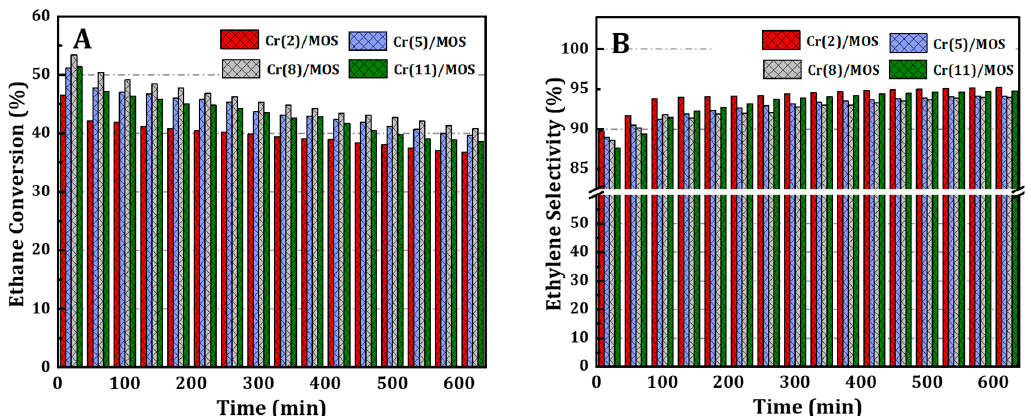
Figure 7. Variation of ethane conversion ( A ) and ethylene selectivity ( B ) time ‐ on ‐ stream over Cr(x)/MOS catalysts. Therefore, slight deactivation of the Cr(x)/MOS catalytic system happened mostly because of the reduction of high ‐ valence Cr 6+ of CrOx species along with coke formation. However, for better understanding of the reasons of deactivation after the reaction, char- acterizations of spent catalyst were compared with the fresh catalyst and the results are included as a supplementary file. Even after 10 h of on ‐ stream operation, Cr(8)/MOS showed high catalytic activity, with 40.81% and 38.37% for the conversion of ethane and yield of ethylene, respectively. CO 2 ‐ based oxidative dehydrogenation of ethane over the Cr(8)/MOS catalyst was also studied at various gas hourly space velocities (GHSV), and the results are presented in Figure 8. The GHSV was altered by changing the reactant flow rate while maintaining